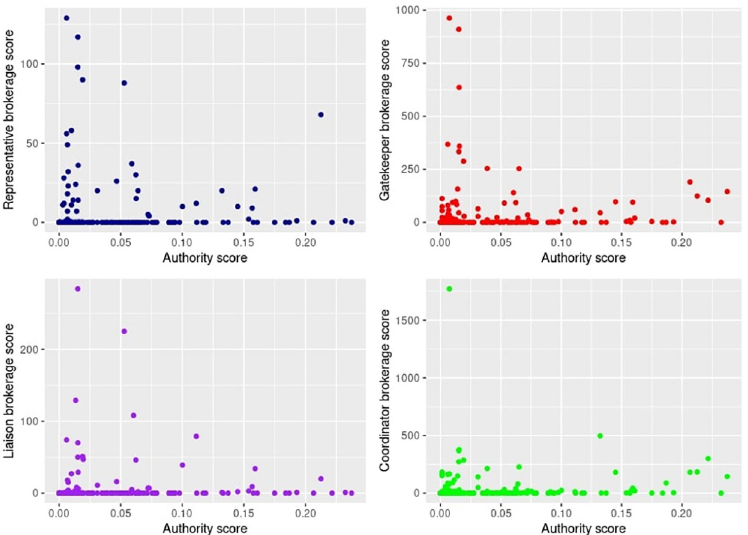
Fig 3. Association between authority scores and brokerage scores for the most politically-salient community in June 2019.